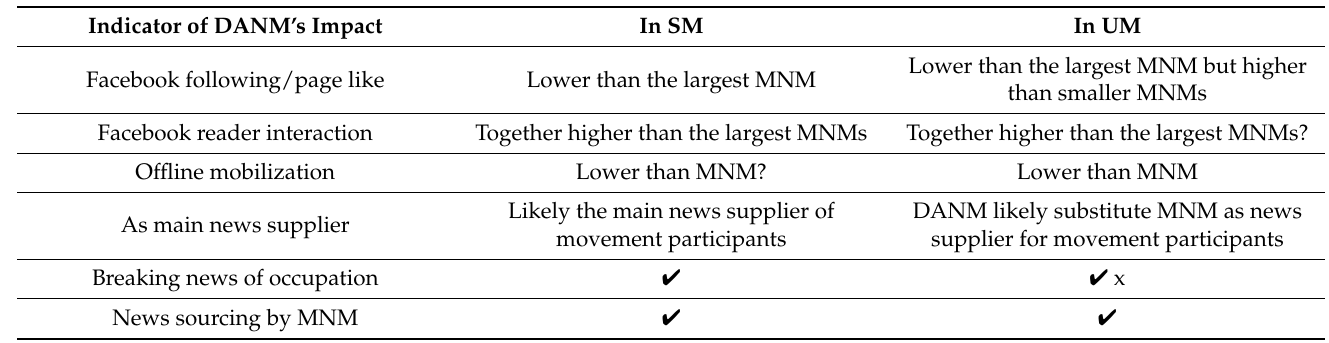
Table 3. Impact of DANM on the Sunflower Movement and the Umbrella